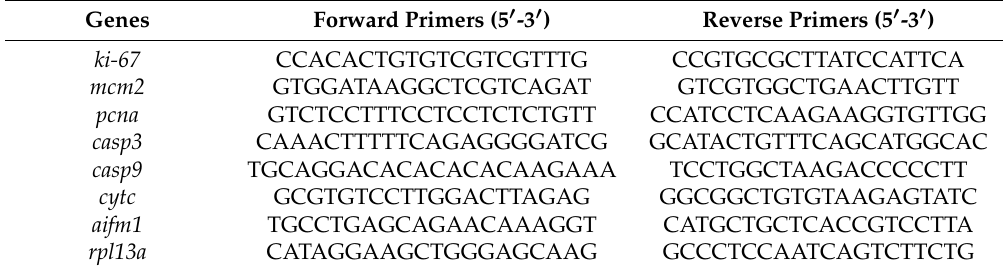
Table 2. Primers used to assess the expression of genes involved in proliferation and type of cell death. Genes Forward Primers (5 (cid:48) -3 (cid:48) ) Reverse Primers (5 (cid:48) -3 (cid:48)